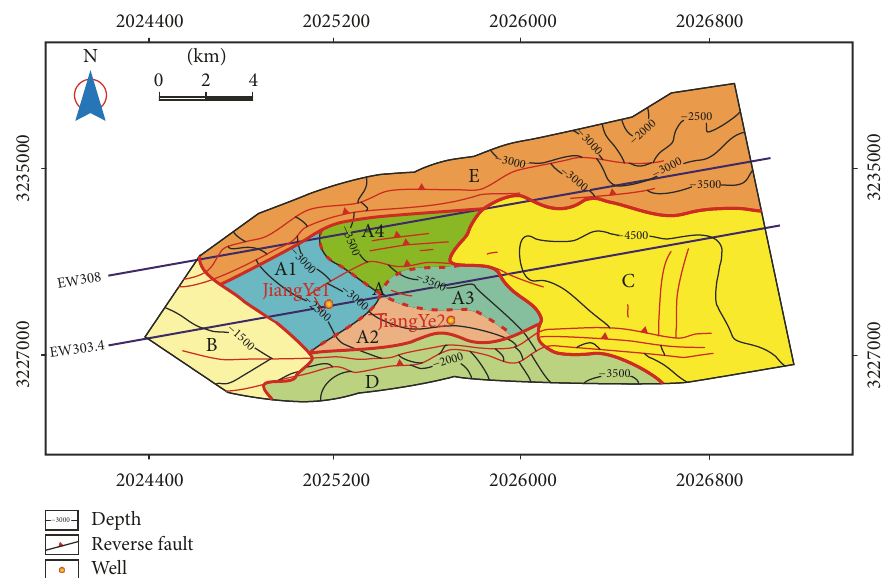
Figure 10: Division of evaluation units of the shale gas area, XiuWu Basin. See Figure 1 for the location.